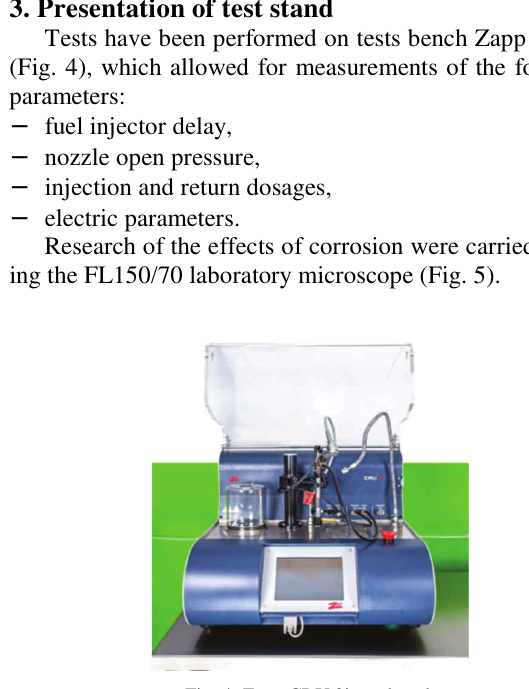
Fig. 4. Zapp CRU 2i test